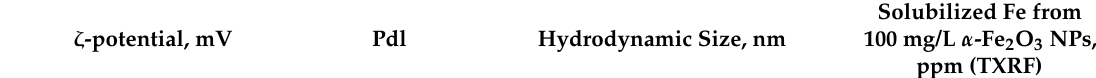
Figure 3. TEM images of the α -Fe 2 O 3 NPs: ( A ) uncoated-positively charged ( α -Fe 2 O 3 - p 70), ( B ) cit- rate coated-negatively charged ( α -Fe 2 O 3 - n 70).